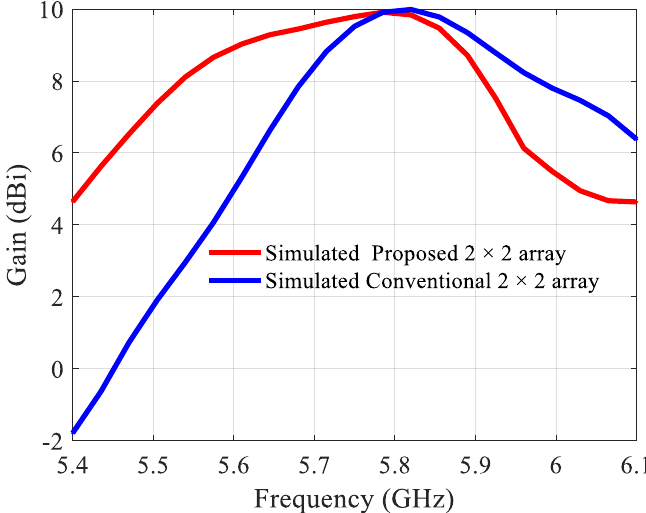
Figure 14. Simulated gain of the conventional and proposed 2 × 2 antenna array.